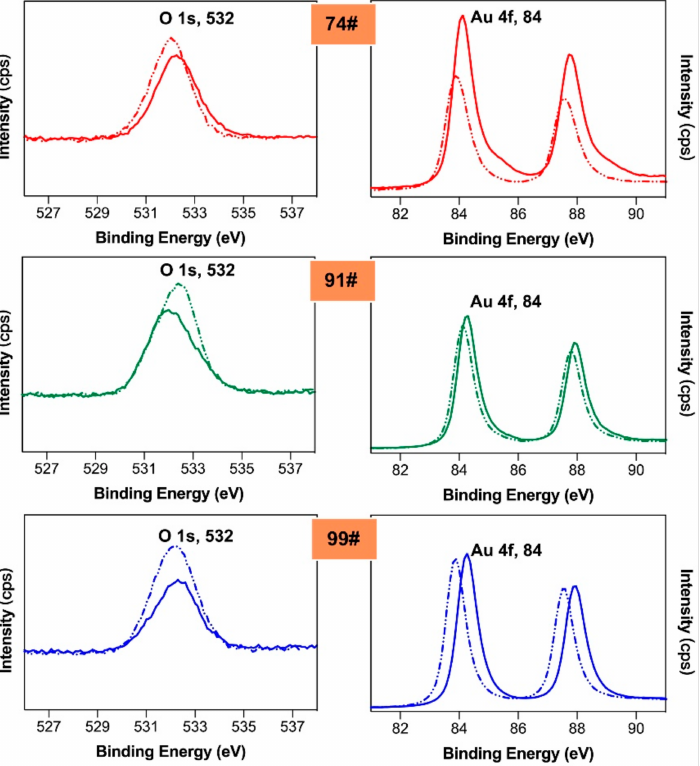
Figure 6. XPS spectra at O 1 s and Au 4 f regions of control (solid lines) and corroded (dash lines) sample under 90% relative